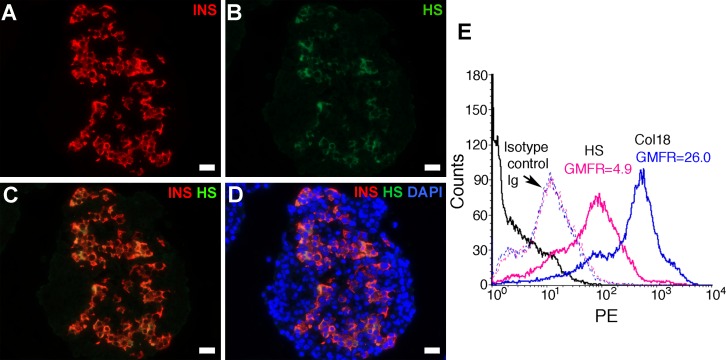
HS and HSPG core protein are localized inside isolated human islet beta cells.Immunofluorescence staining of 1 day-cultured isolated human islets show co-localization of (A) insulin (INS) and (B) HS. Nuclei were stained with DAPI (D). (A) anti-insulin Ab; (B) 10E4 anti-HS mAb; (C) merged (excluding DAPI); (D) merged (including DAPI). Scale bar = 20 μm. (E) Representative single color flow cytometry histograms of freshly isolated human islet cells (89% were NG-positive beta cells) show staining for intracellular HS (pink solid line) and Col18 (blue solid line) compared to background staining with corresponding isotype control Ig (dotted lines) and the autofluorescence of unstained cells (black solid line).